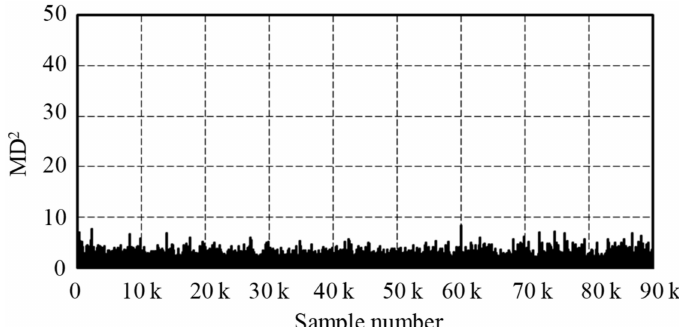
Figure 21. MD 2 of the time-series data under the normal condition: In this result, the trends of the MD 2 values during the nine days of normal operation are removed by the filtering and appear to be relatively constant.